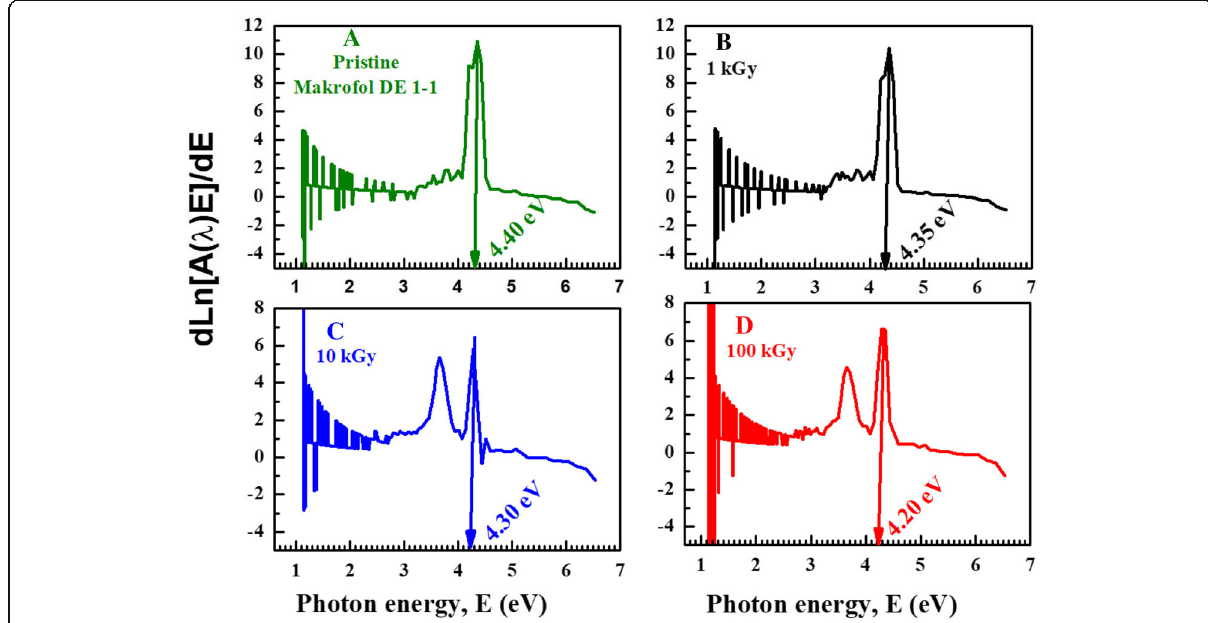
Fig. 10 Variation of dln[( A ( λ ) E )]/d E with ( E ): a pristine, b 1 kGy, c 10 kGy, and d 100 kGy Makrofol DE 1-1 samples irradiated with gamma rays